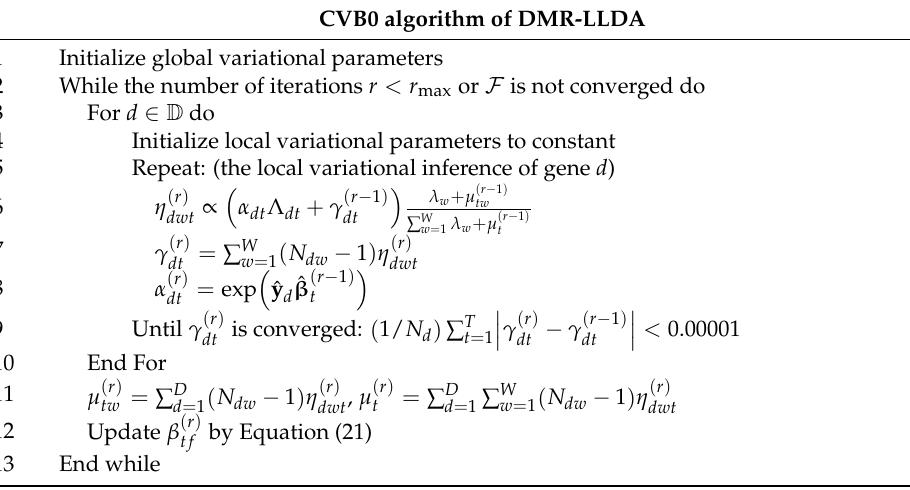
Table 2. Zero-order variational Bayesian (CVB0) algorithm of